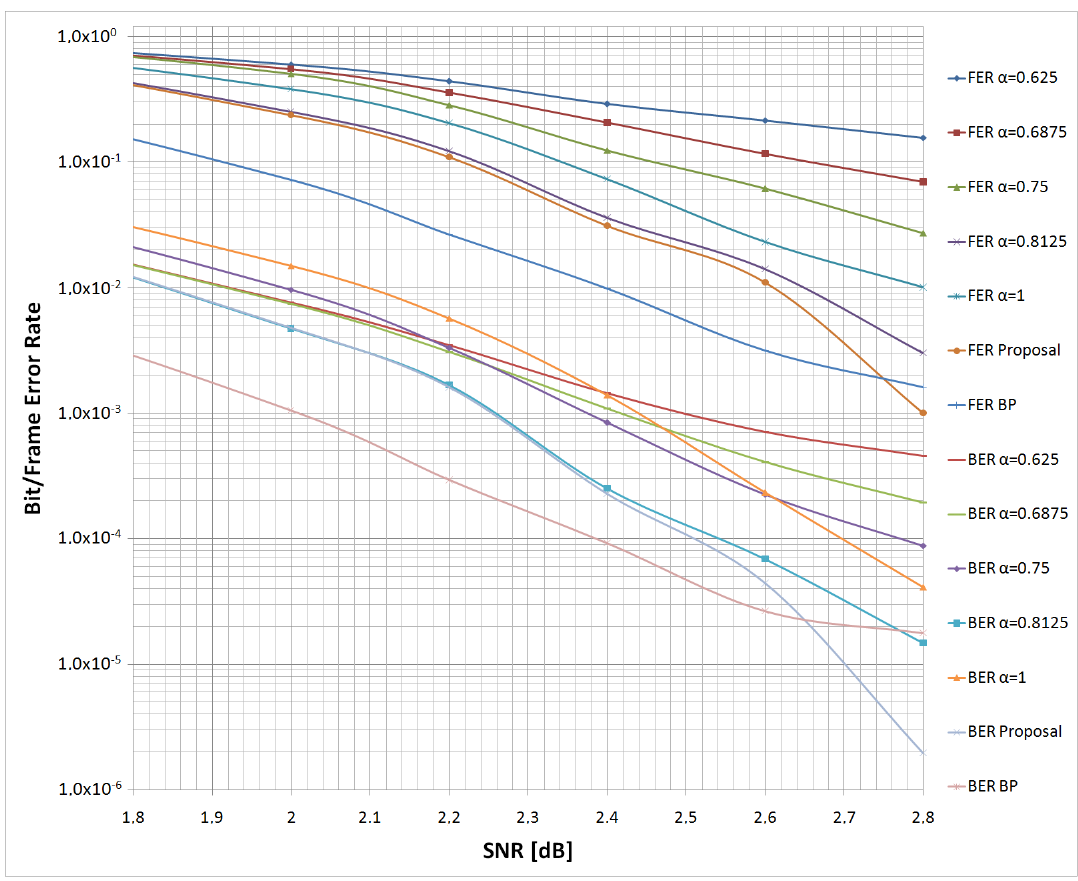
Figure 13. BER and FER chart of the QC-LDPC decoder for the Min-Sum algorithm and variants of the Normalized Min-Sum